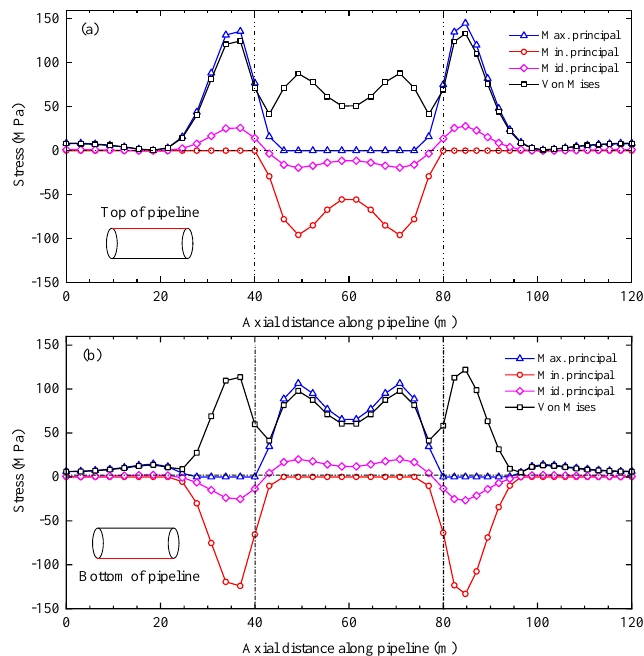
Figure 10. The stresses on the top ( a ) and bottom ( b ) of the pipeline in the 10th year after pipeline construction.